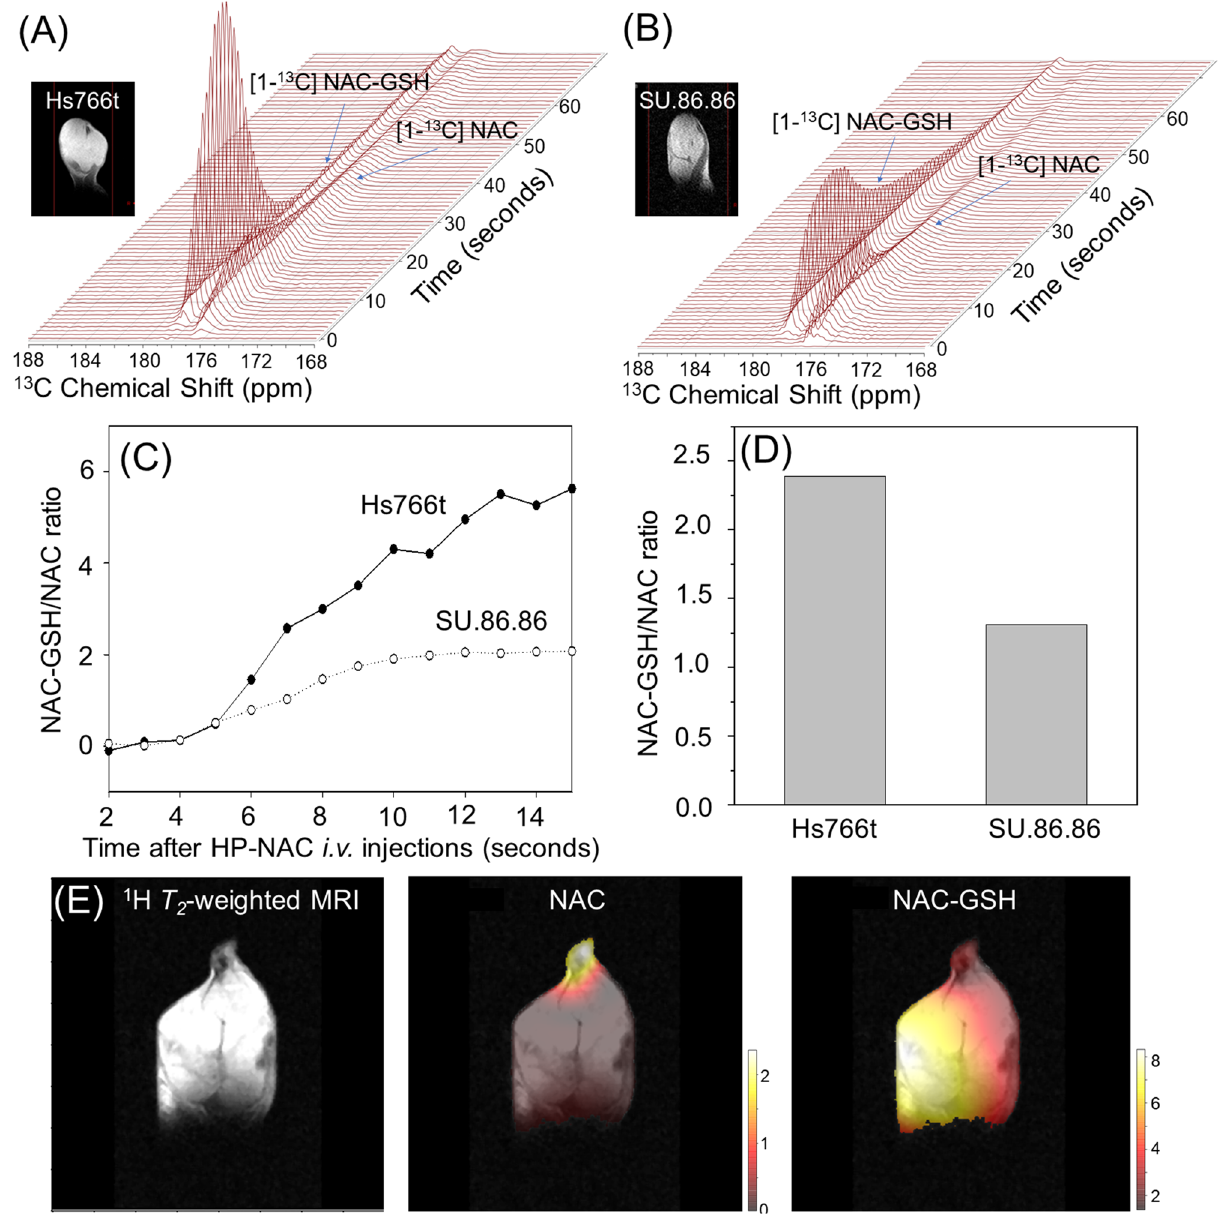
Figure 4. Real-time observation of NAC metabolism effectively probes redox status in tumors in vivo. Dynamic 13 C MR spectra of hyperpolarized [1- 13 C] NAC at 3 T MRI on human pancreatic tumor xenografts of Hs766t ( A ) and SU.86.86 ( B ). Differences in the conversions reflect the redox status of each tumor. ( C ) Time dependence of NAC-GSH/NAC peak intensity ratio after the iv injection of HP-NAC. ( D ) Comparison of the ratios of NAC-GSH to NAC between Hs766t and SU.86.86 tumor xenografts. ( E ) Site-specific differences in chemical conversions of hyperpolarized [1- 13 C] NAC by 13 C Chemical shift imaging in Hs766t